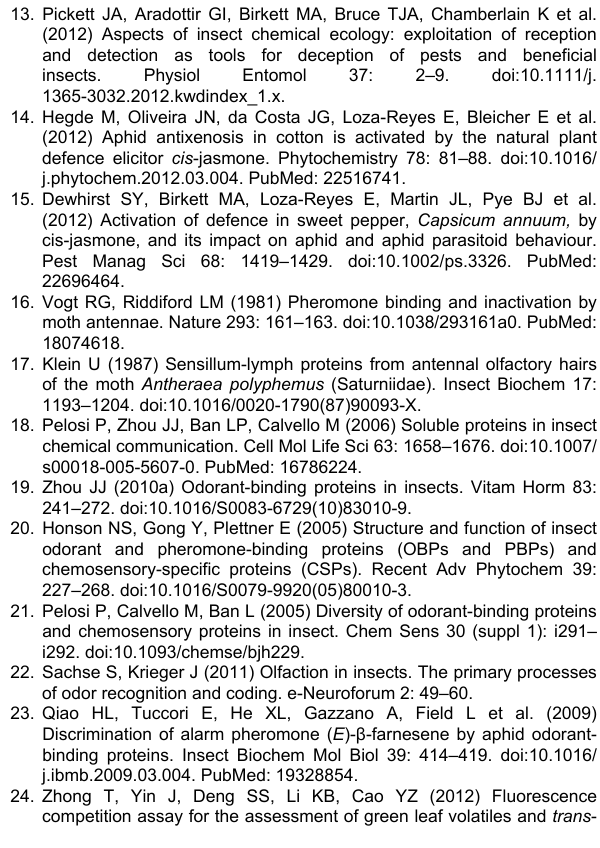
Table S4. A percent identity matrix of A. gossypii CSPs.